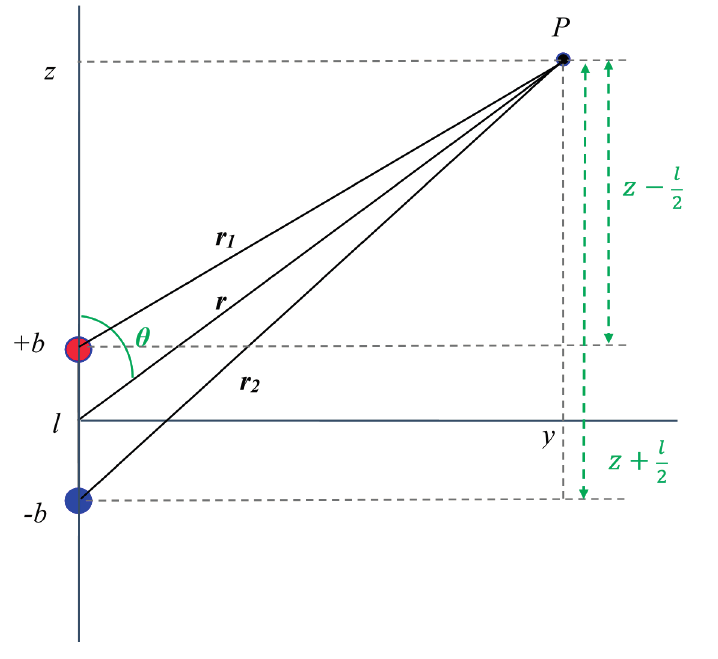
Figure 3. Distances of point P from the origin and the two